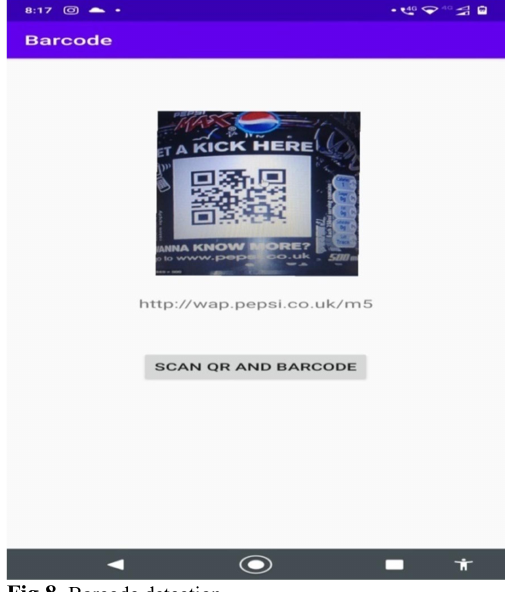
Fig 8 Barcode detection Performance of our application compared to others